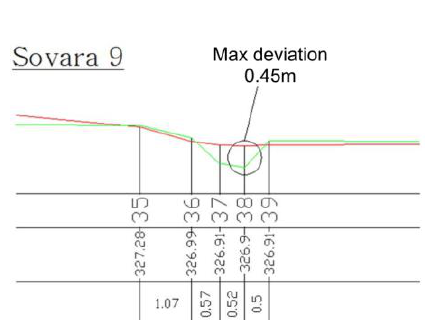
Figure 14. Example of drainage ditch